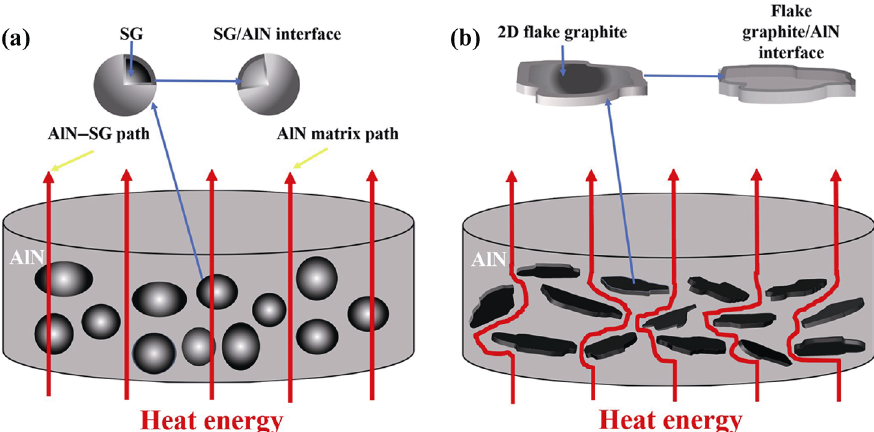
Fig. 12 Schematic diagrams of thermally conductive paths in composite filled with different shaped second phases: (a) spherical graphite and (b) 2D flake graphite.